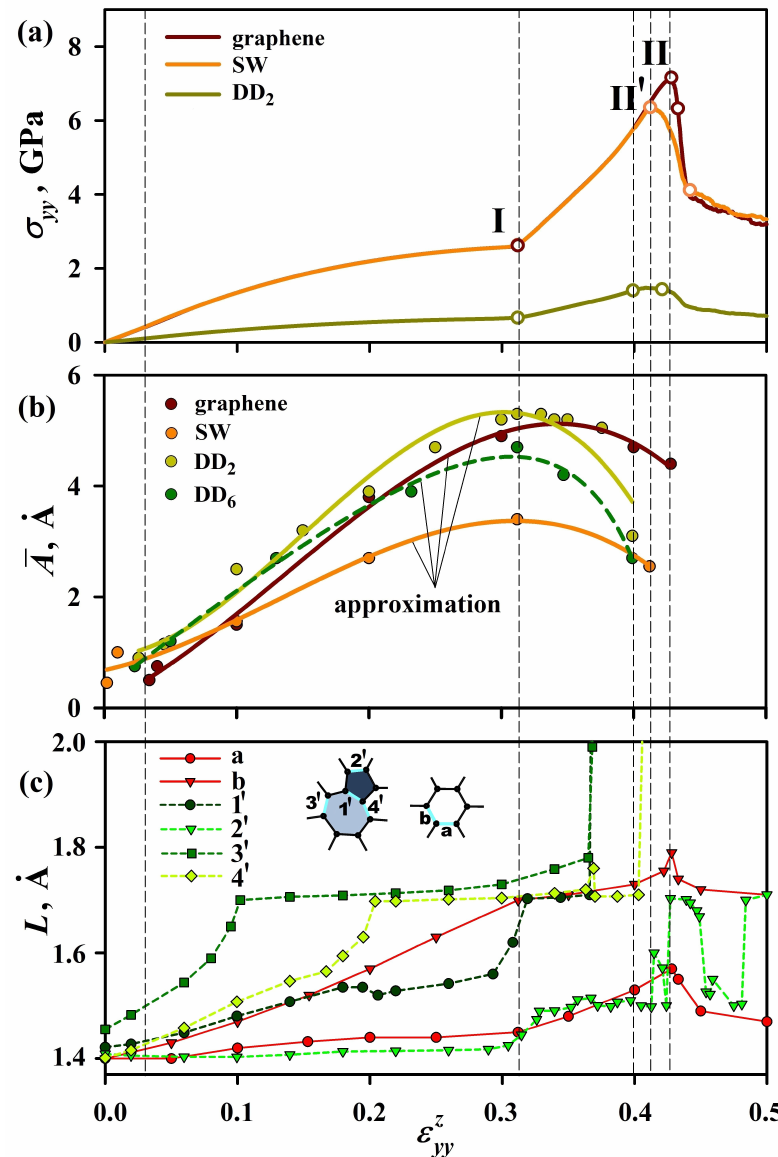
Figure 7. ( a ) Stress-strain curves for graphene, graphene with SW, and DD 2 under tension along zigzag direction at T = 0 K. ( b ) Average amplitude A of ripples for defect-free graphene, graphene with SW, and DD 2 as the function of strain under tension along zigzag direction at T = 0 K. Numerical data are shown by dots, while approximations are shown by solid lines. One more structure with the dipole (DD 6 ) is added for comparison with the approximation shown by a thick dashed line. The thin black dashed lines show different deformation regimes. ( c ) The bond length in graphene and graphene with DD 2 as the function of applied tensile